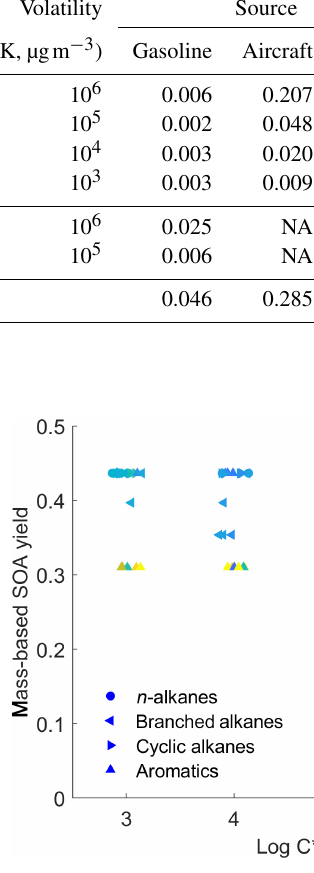
Figure 1. Scatter plot of first-generation mass-based SOA yields versus volatility (log C ∗ , µgm − 3 ) in the detailed parameterization (dots are colored by OH reaction